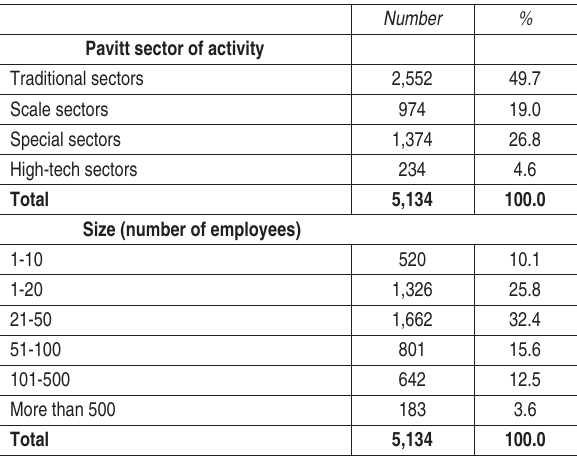
Table 1. Number of companies present in the dataset by Pavitt sector and firm size. Year